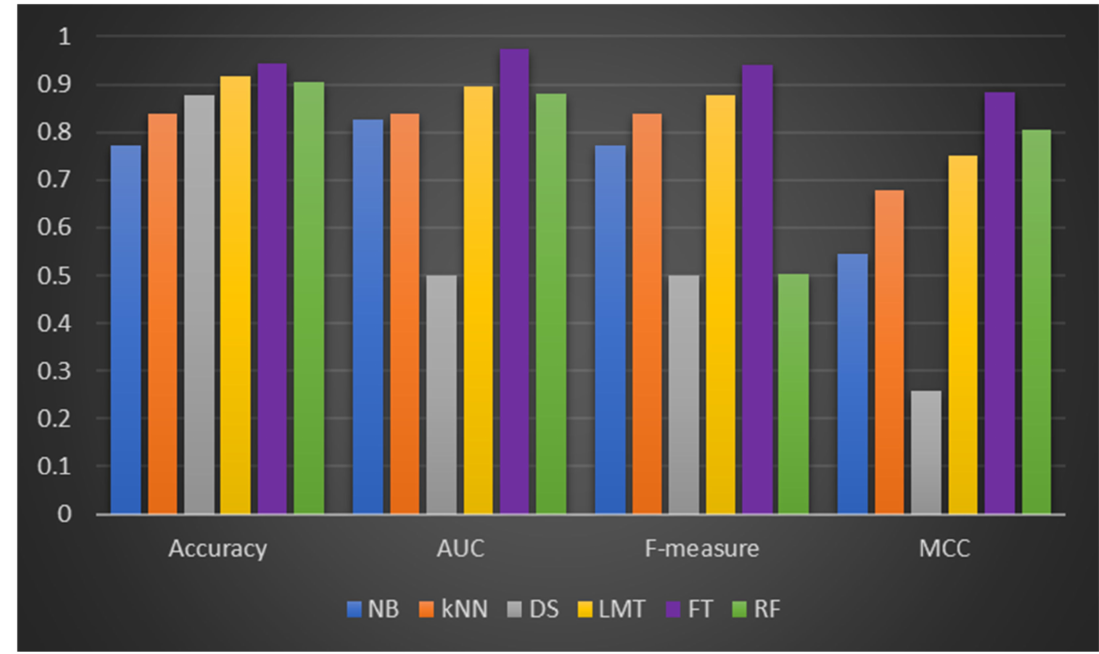
Figure 5. CCP Performance of DF models and ML Classifiers on balanced (SMOTE) Dataset